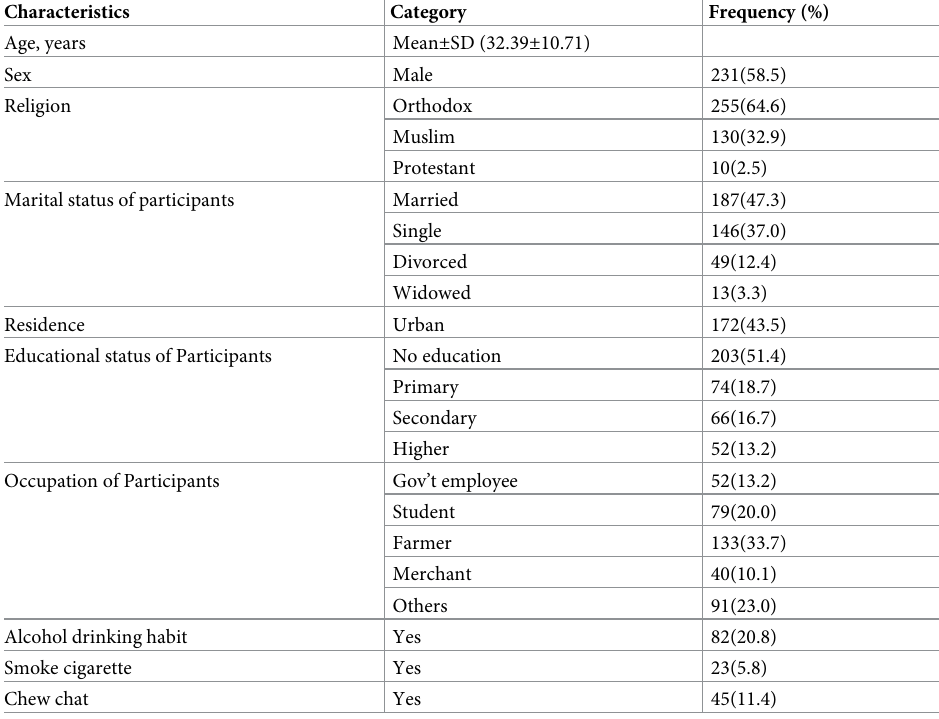
Table 1. Sociodemographic and behavioral characteristics of epileptic patients ( n = 395).